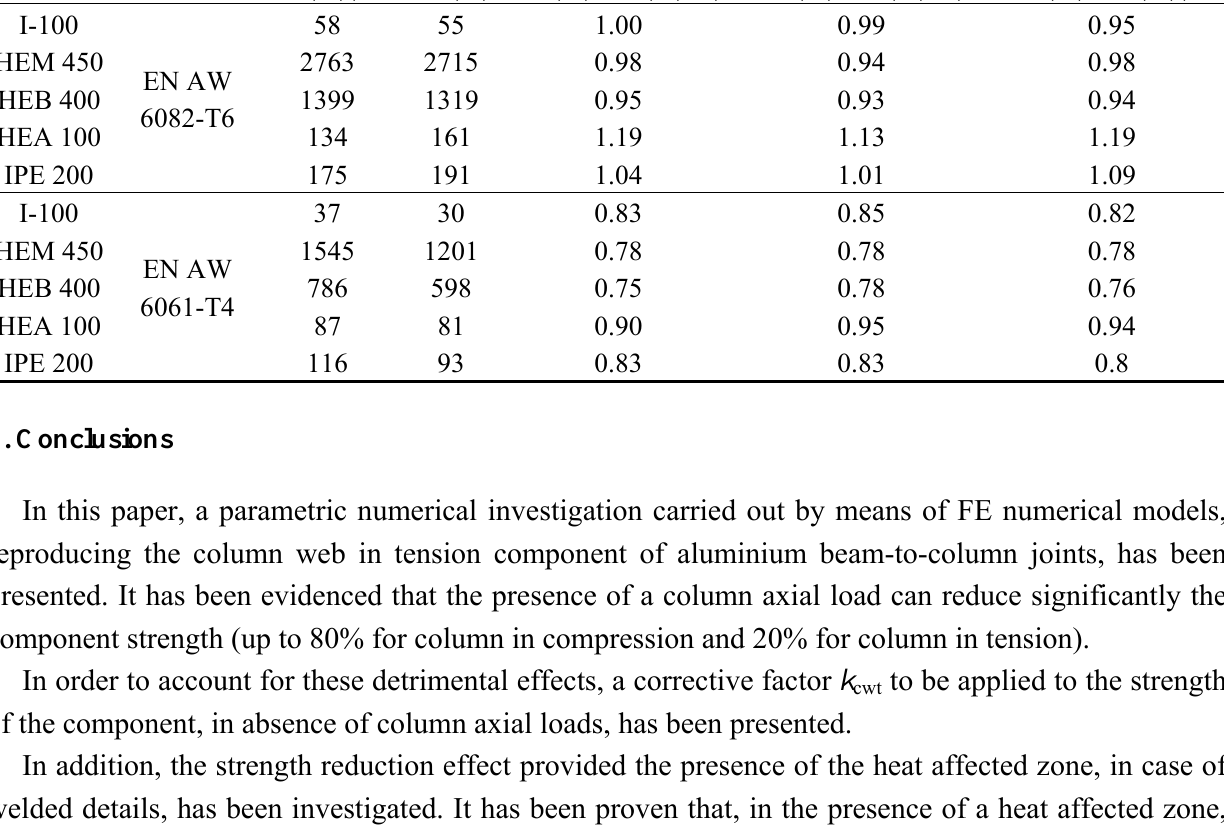
Table 1. Numerical vs. Analytical (Equation (9)) strength of heat affected aluminium specimens.